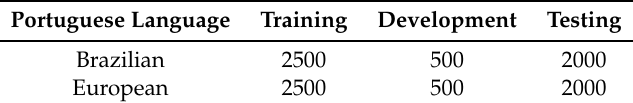
Table 1. The ASSIN corpus.